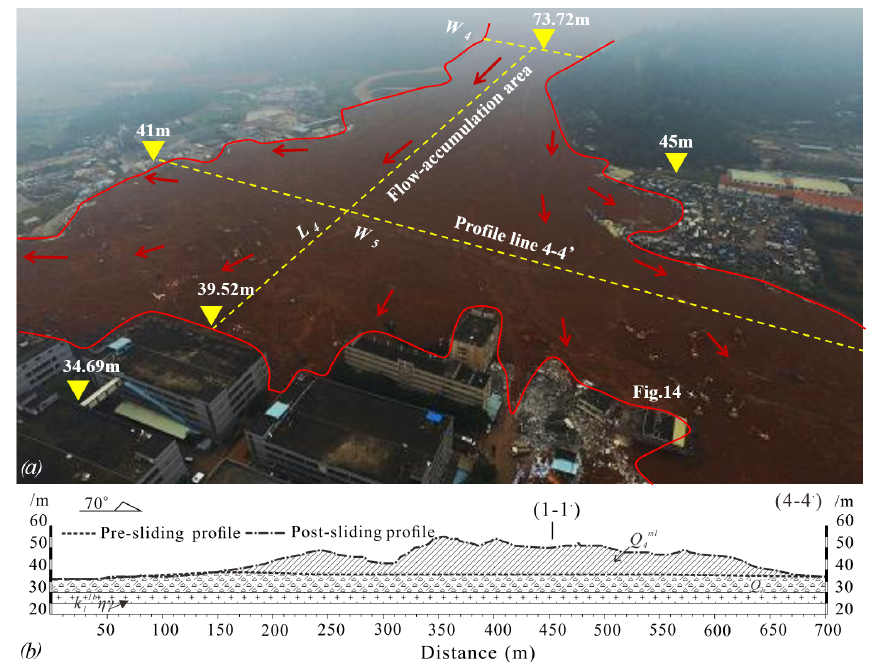
Figure 14. (a) Overview of the flow-accumulation area with elevations (China News Agency); (b) geological cross section (profile line 4-4’) of the flow-accumulation area. The length ( L 4 ) was 664.4m, and the width ( W 3 ) was 218.3m, with the width of the front edge ( W 5 ) being 592.3m. The area was 28.51 × 10 4 m 2 , and the elevation difference ( H 4 ) was 35.7m with an apparent dip ( (cid:56) 6 ) of 3.08 ◦ . The average thickness was 8.21m with the maximum thickness of 18.82m (Fig. 12c, Table 1, and Table 3).